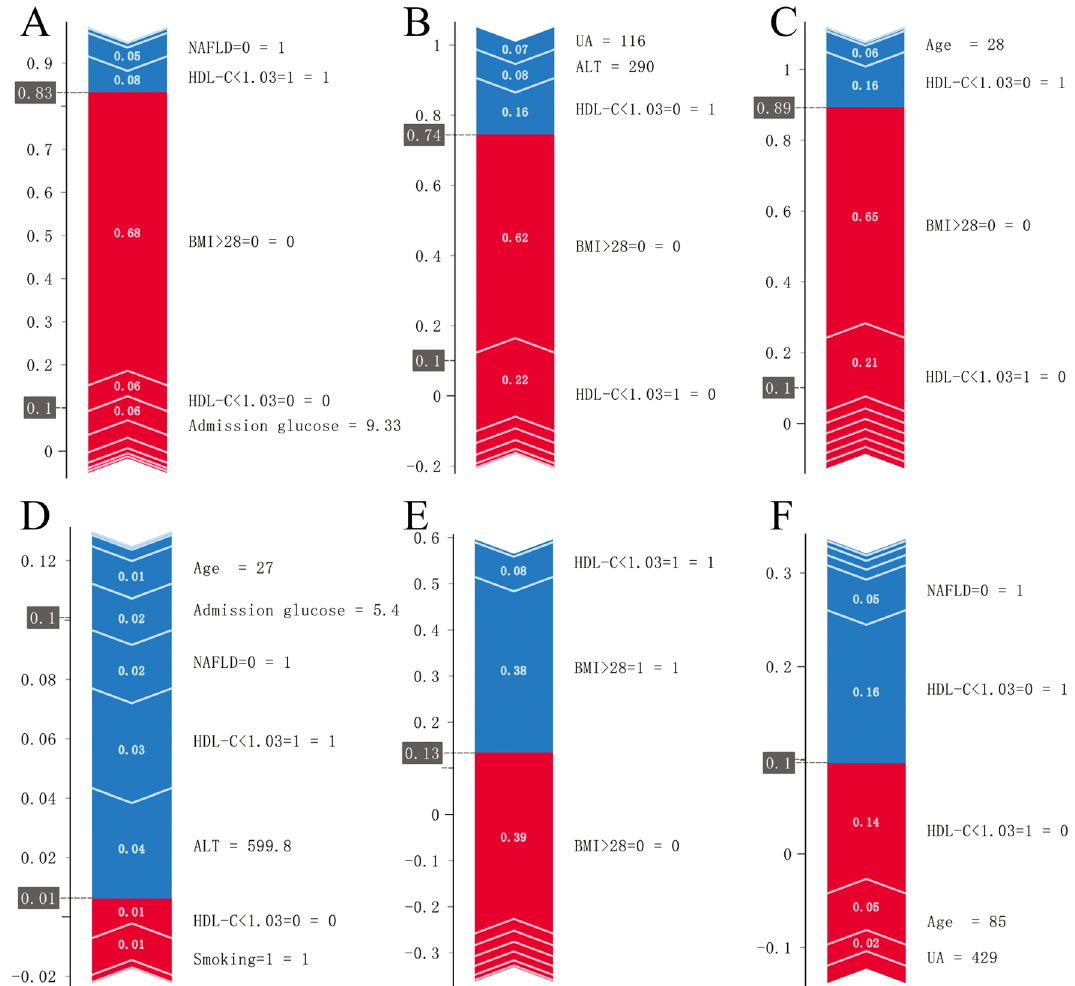
Figure 4. Personalized diagnosis. The risk factors for the three positive and three negative predicted samples in the prediction set were studied. ( A ) Patient 1 had a BMI > 28 kg/m 2 as the main risk factor and a predicted probability of developing diabetes of 0.83. ( B ) Patient 2 had a BMI > 28 kg/m 2 , HDL-C > 1.03 mmol/l as the main factor and a predicted probability of developing diabetes of 0.74. ( C ) Patient 3 had a BMI > 28 kg/m 2 as the main risk factor and a predicted probability of developing diabetes of 0.89. ( D , E , F ) Patient 4, Patient 5, Patient 6 have no factors that make a major contribution to predicting a positive event and all have a predicted probability of developing diabetes of less than 0.13. The contribution of risk factors to this patient can be observed in the graph. Red represents the positive contribution and blue represents the negative (Fig. 4D,E,F). The probability of predicting the occurrence of PPDM-A in each of these samples was less than 0.13. Discussion